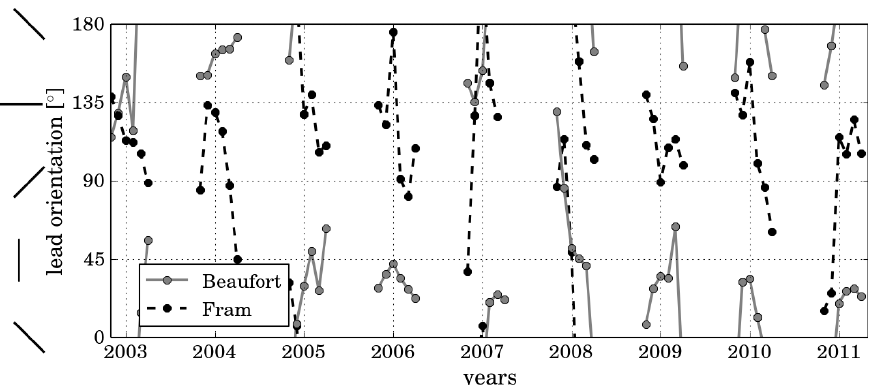
Figure 12. Time series of monthly averaged lead orientations in sub regions of the Beaufort Sea (black dashed) and the Fram Strait (gray) from 2002 to 2011. Both, 0 ◦ and 180 ◦ , are orientated parallel to Greenwich meridian. The precise location of the two sub regions is indicated by boxes in Figure 10. The lines on the left hand side illustrate the corresponding lead